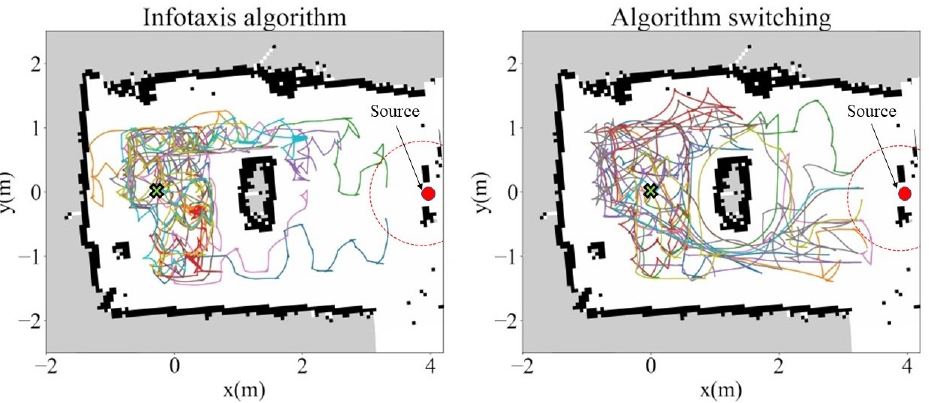
Figure 16. Trajectories of the robot in two cases, with ten trials conducted for each case. The dashed red lines indicate the target radii.